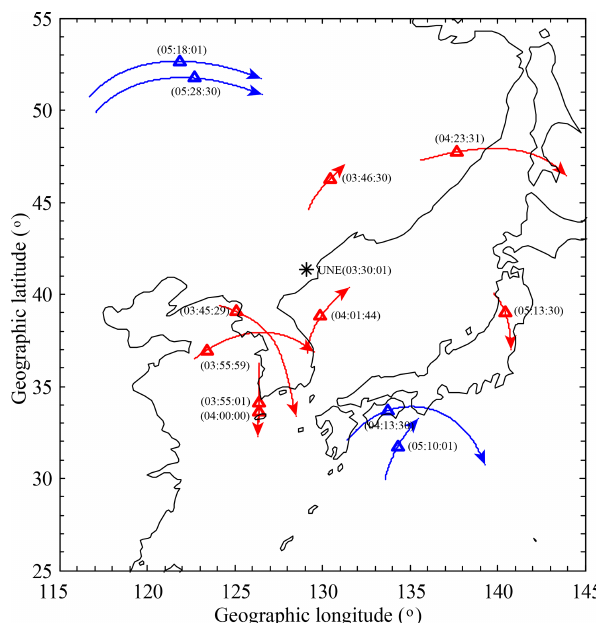
Figure 5. The IPP tracks of relative STEC derivatives. The red lines indicate the IPP tracks obtained by IGS stations in the Northern Hemisphere. The blue lines indicate the magnetic conjugate posi- tions of the IPP tracks obtained by IGS stations in the Southern Hemisphere. The positions of the maximum amplitudes of relative STEC derivatives in the Northern Hemisphere are represented by red triangles. The geomagnetic conjugate positions of the maxi- mum amplitudes of relative STEC derivatives in the Southern Hemi- sphere are represented by blue